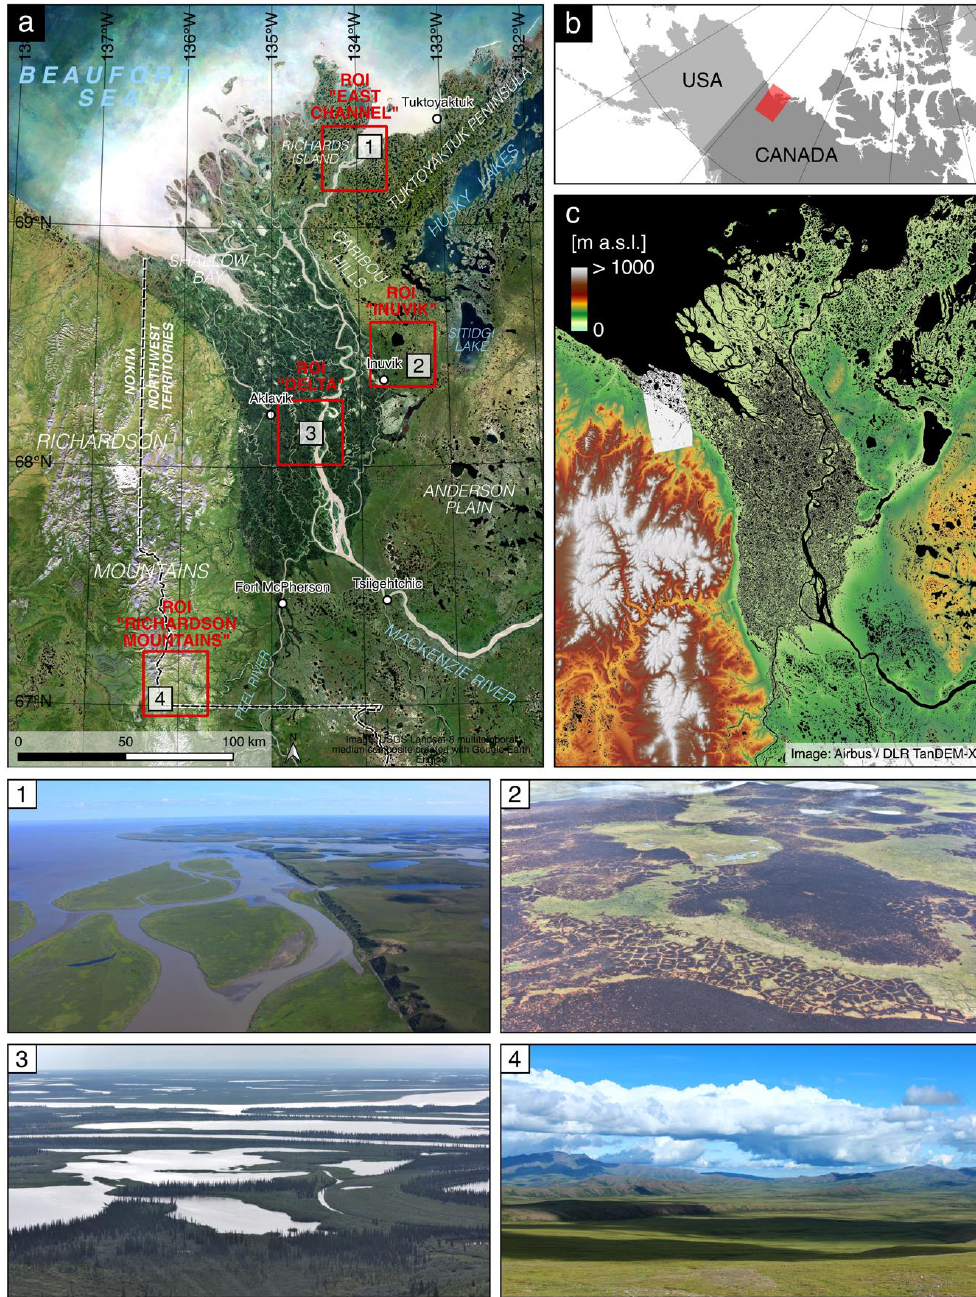
Figure 1. Mackenzie Delta Region: ( a ) Landsat-8 RGB true-color image composite of the study area and ( b ) overview. Subregions are highlighted by red polygons in ( a ), and photographs) of the subregions are numbered from 1–4 (bottom). Subfigure ( c ) displays the TanDEM-X digital elevation model ( © DLR 2016) superimposed by the water-mask (black). Photography by T. Ullmann 2012, 2013, 2018.